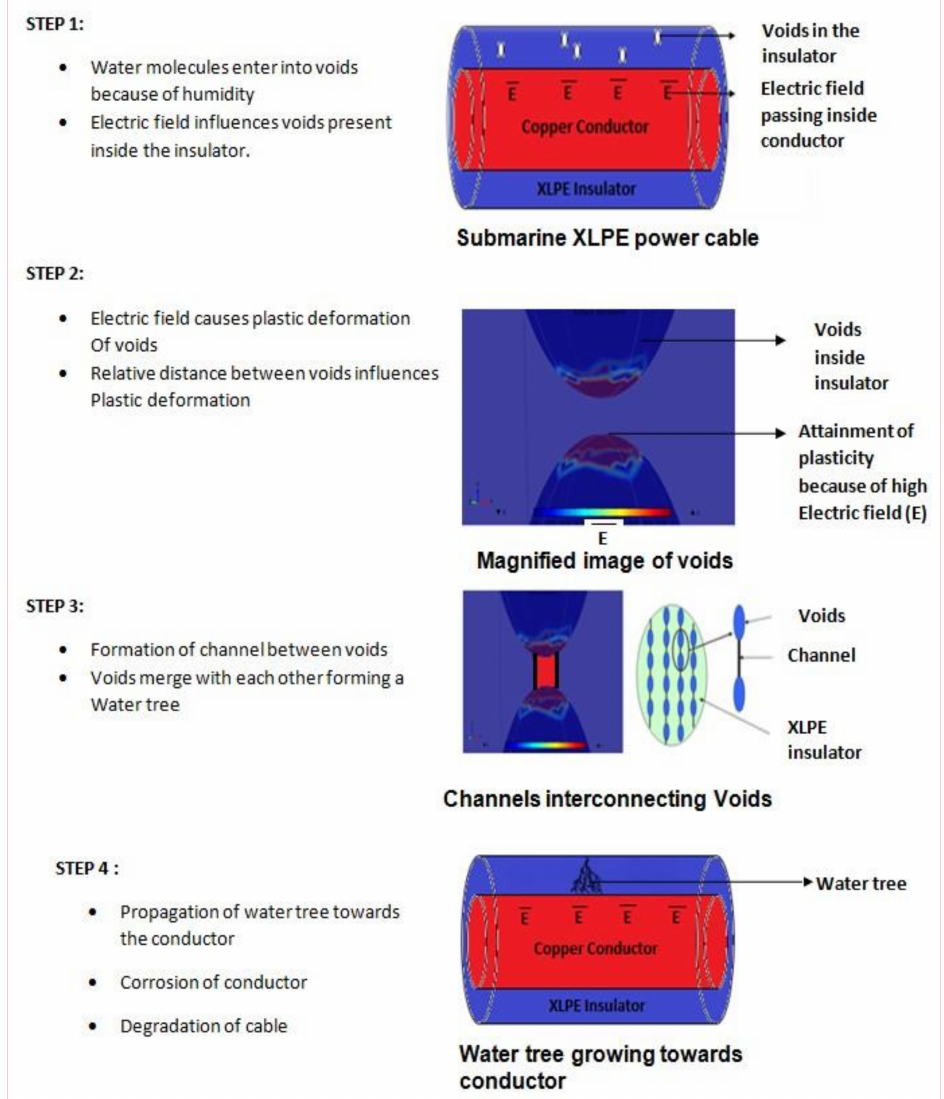
Figure 3. Schematic representation of steps involved in the growth of water trees and used to model water voids in an insulator. Information about geometrical, material, and modelling parameters is detailed in the next section. This work also aims at studying the minimum distance between voids that results in the void’s